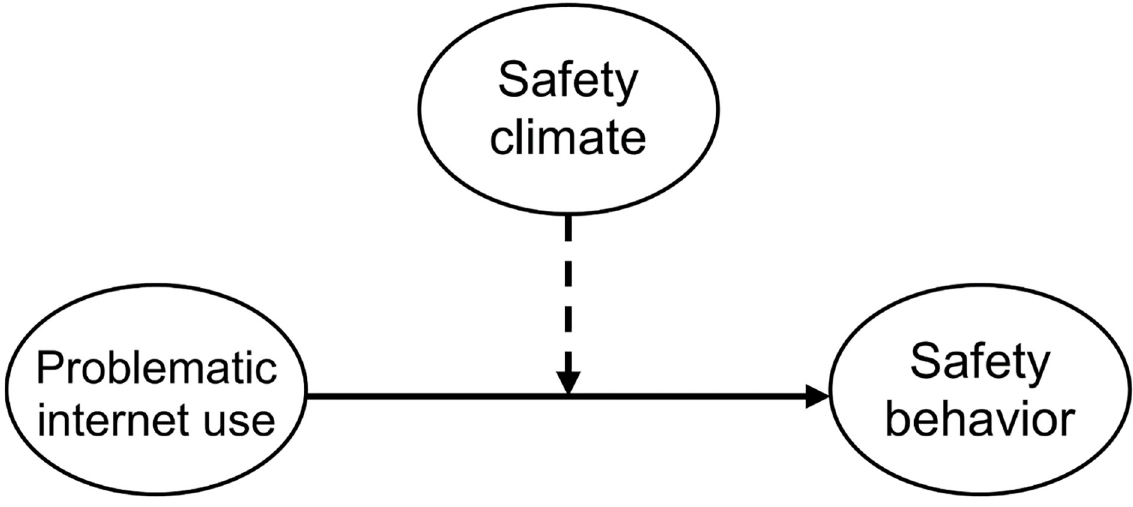
Fig 1. The hypothetical